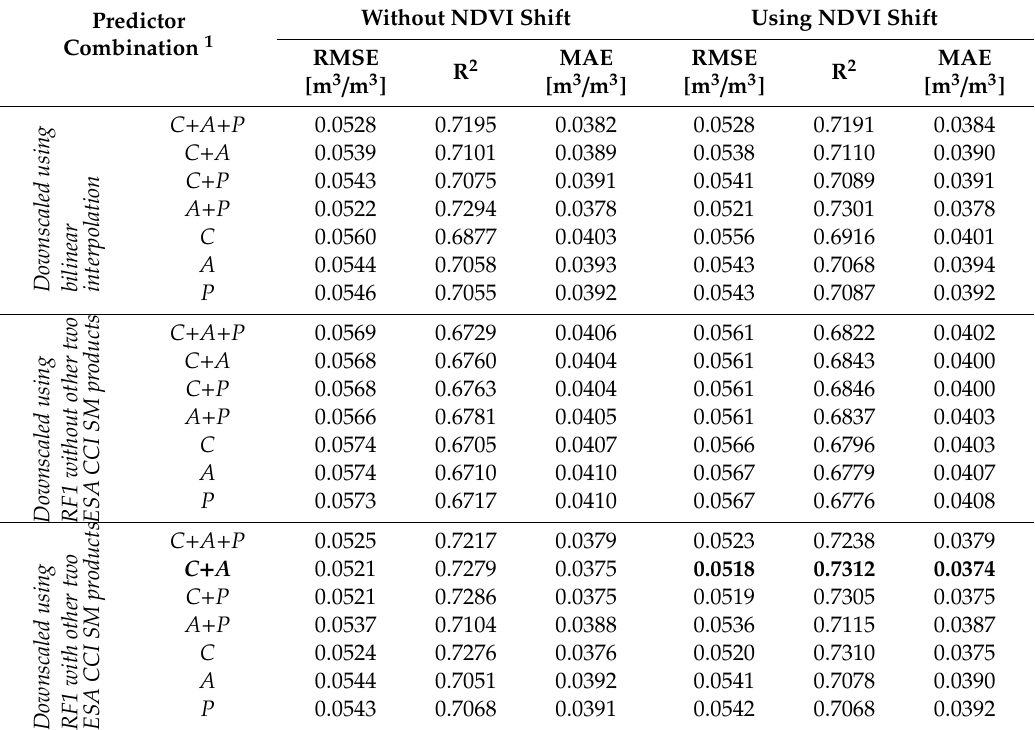
Table 2. Validation metrics for each set of tested predictors (results after applying second RF).